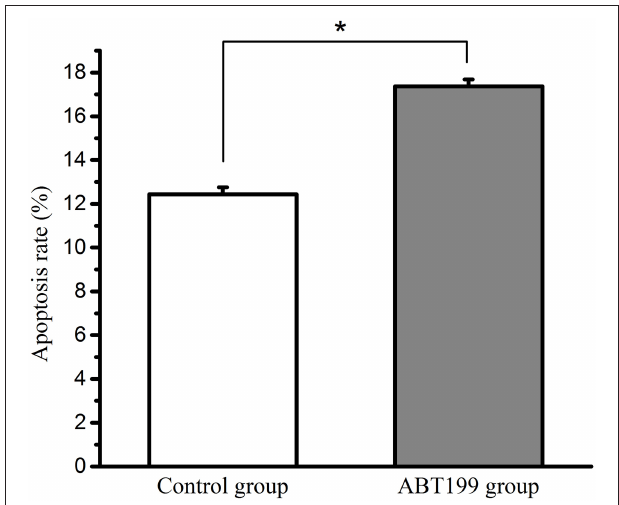
FIGURE 8 | The apoptosis rate of haemocytes in the ABT199-treated group and the control group. Error bars represent the SD. Asterisks (*) represent a significant difference between the ABT199-treated group and the control group ( P <